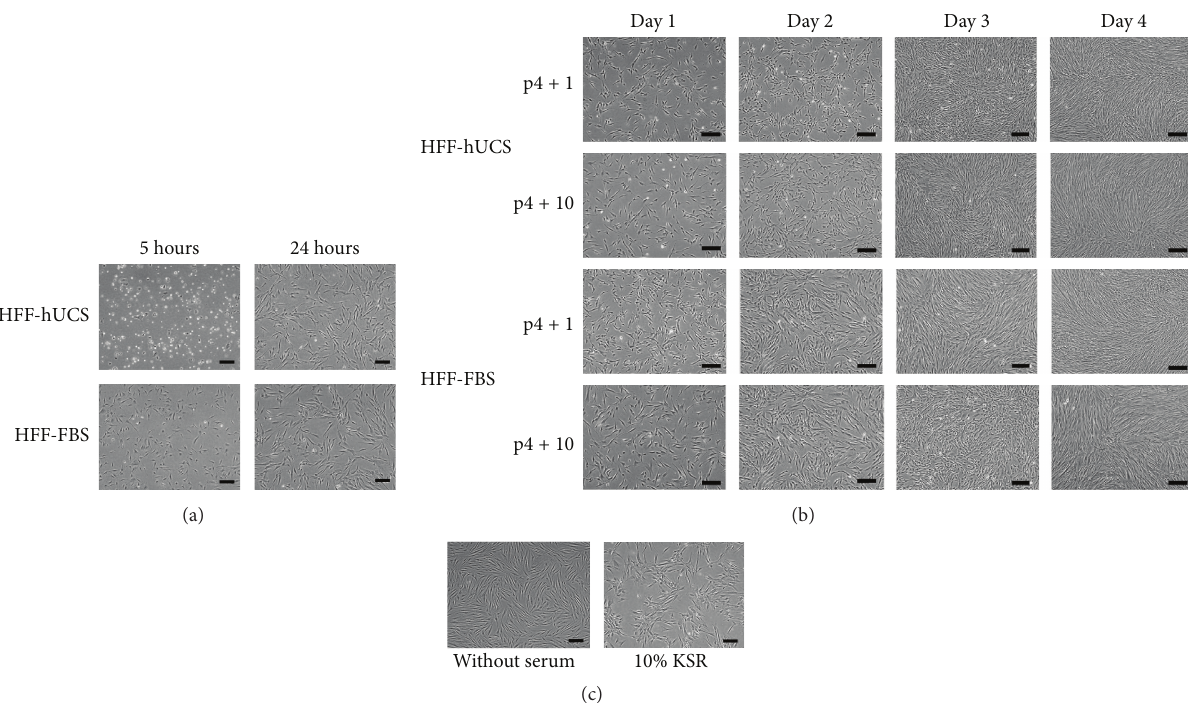
Figure 1: Effect of serum supplementation on the growth kinetics of human foreskin fibroblasts. Human foreskin fibroblasts were enzymatically dissociated and plated onto culture dishes. HFFs were cultured in the media containing human cord blood-derived serum (hUCS; HFF-hUCS), fetal bovine serum (FBS; HFF-FBS), knockout serum replacement (KSR) or without serum supplementation. Dissociated cells were observed for attachment behavior and growth kinetics. Differences in cell attachment between HFF-hUCS and HFF- FBS were observed. At 5 hours after plating, nearly all of the dissociated HFF-FBS were attached to the surface of the culture dish and exhibited a fibroblastic-like morphology, while most of HFF-hUCS remained suspended in the culture medium. At 24 hours after plating, all HFF-FBS and HFF-hUCS were attached to the culture dishes and displayed typical fibroblast cell morphology (a). Similar proliferation patterns between HFF-hUCS and HFF-FBS were observed. HFF-hUCS and HFF-FBS progressively proliferated and reached confluency at 3 to 4 days after seeding. The proliferation behavior at early passage (p4 + 1) was similar to that at intermediate passage (p4 + 10) (b). In contrast to HFF-hUCS and HFF-FBS, HFFs cultured in the medium containing 10% KSR and without serum supplementation could not reach the confluency even being cultured for 7 days (c). HFF = human foreskin fibroblasts, FBS = fetal bovine serum, hUCS = human cord blood-derived serum, KSR = knockout serum replacement, and p = passage number. Scale bars = 200 𝜇